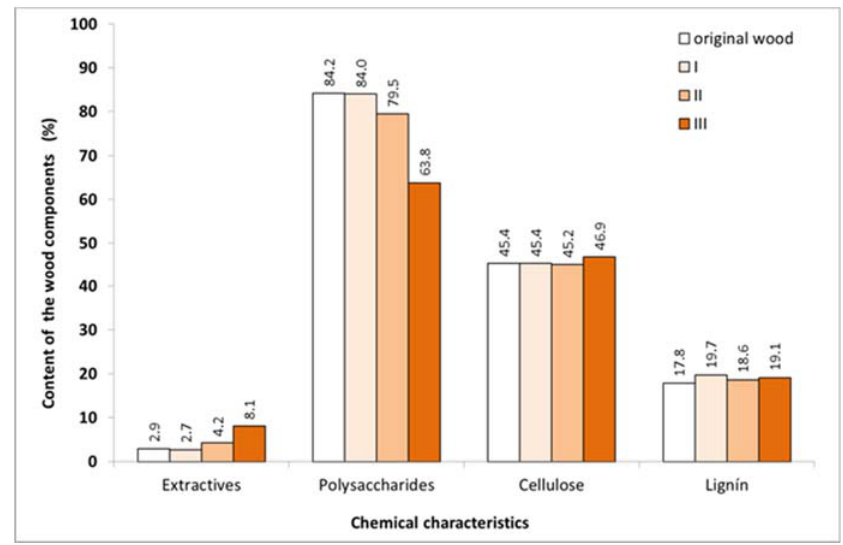
Figure 1. Chemical characteristics of original birch wood and after steaming.